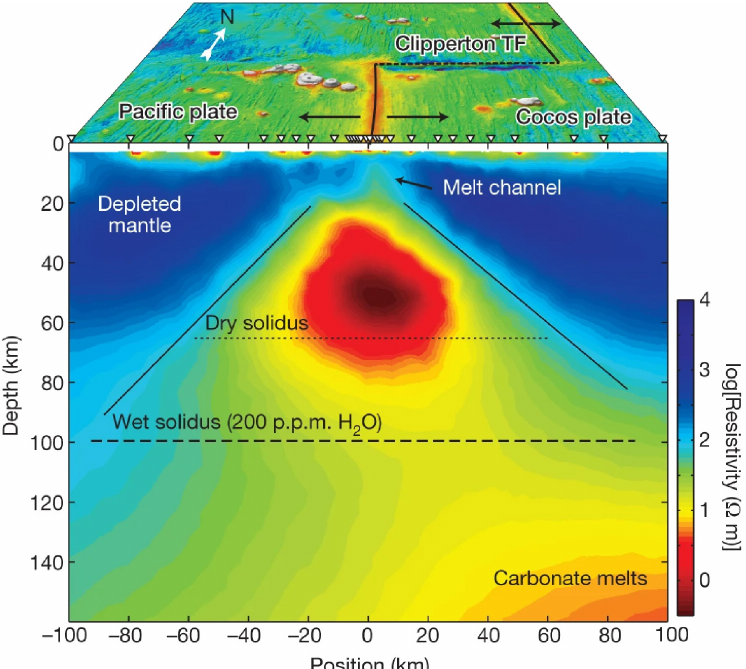
Figure 8. MT resistivity model beneath the east Pacific Rise and the related interpretation after Key et al.